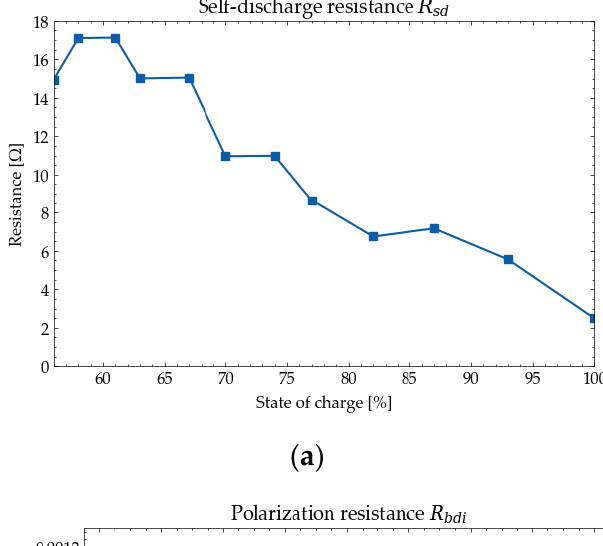
12 of 29 Figure 5. Equivalent circuit topology of the model used for lead – acid battery cell. The extracted equations for the calculation of OPzS parameter values during battery operation are: